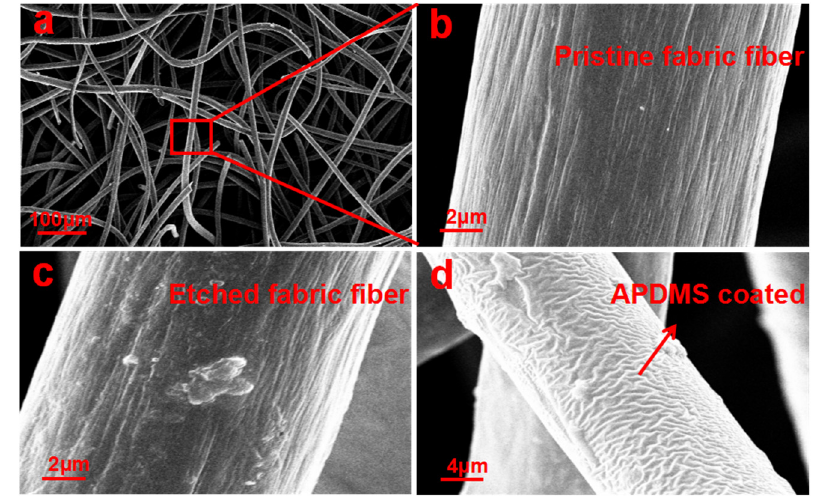
Figure 2. SEM images of pristine CF ( a , b ), E-CF ( c ), and A-CF ( d ).